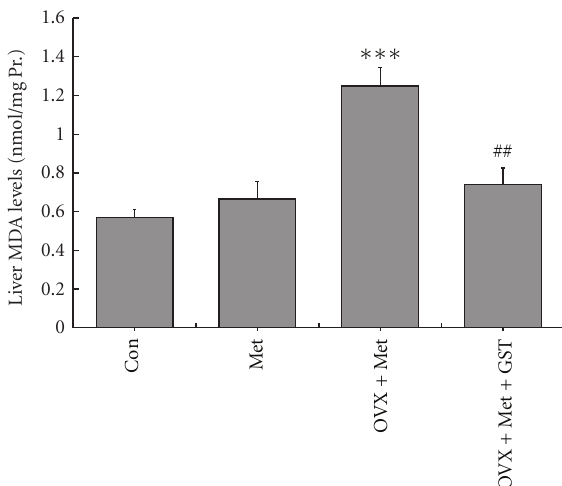
Figure 7: Alterations of liver MDA levels after 12 wk di ff erent treatment. There was a significant increase of liver MDA levels in ovariectomized HHcy rats. Genistein supplementation could significantly lower the elevated MDA levels. The results are shown as mean ± SEM, n = 8. P values were obtained by one-way ANOVA analysis. ∗∗∗ P < 0 . 001 versus Met; ## P < 0 . 01 versus OVX +